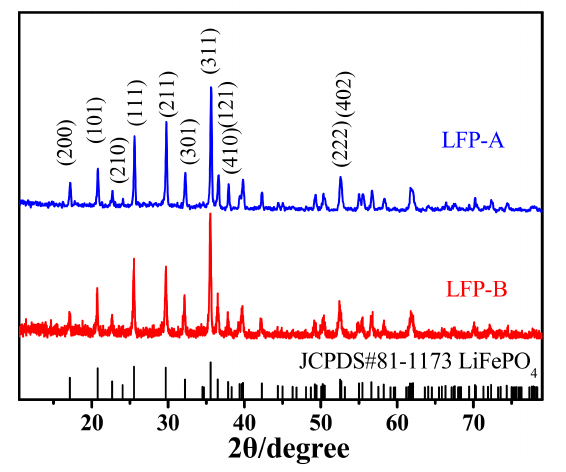
Figure 1. XRD patterns of LFP-A and